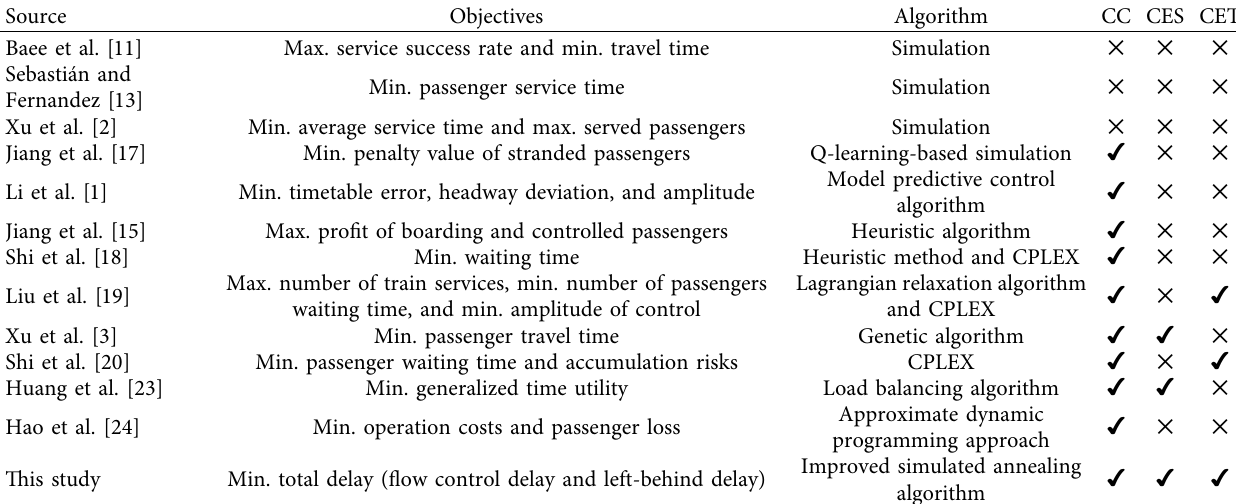
Table 1: Overview of the existing flow control